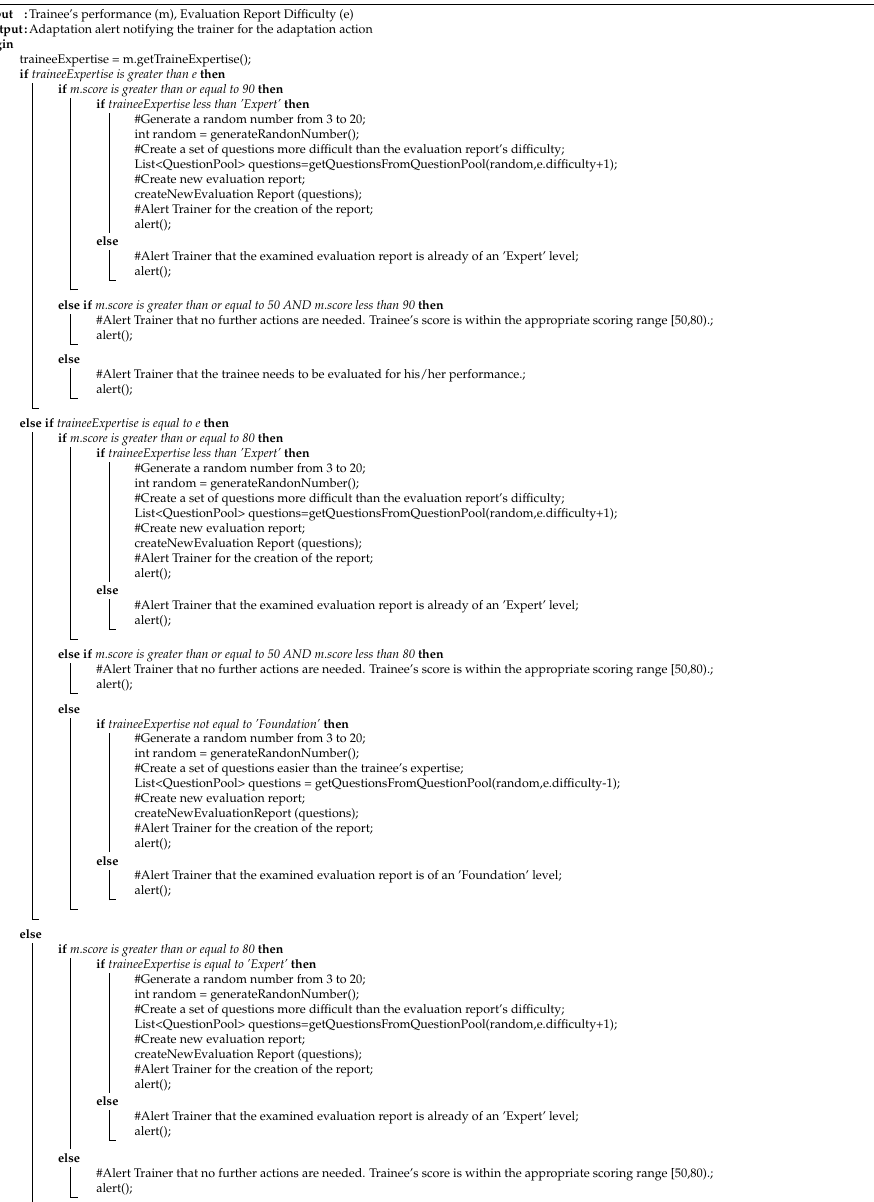
Algorithm 5: Adaptation based on the evaluation report’s